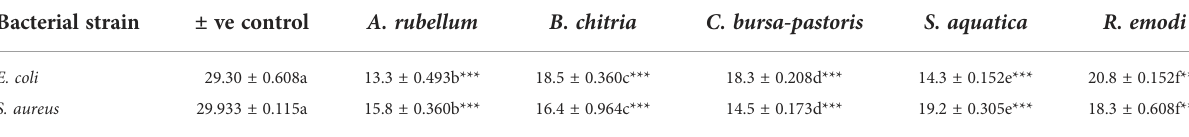
Data are mean ±SD ofthreereplicates (n= 3)and analyzed using GraphPadPrism 5.2bytwo-way ANOVA followed byBonferroni multiple comparison post-testwith a signi fi cance level of ***p < 0.001. Different lowercase letters in a table indicate signi fi cant difference between control and species. Zones of inhibition (mm) are presented as mean ± SEM. E. coli, Escherichia coli; S. aureus, Staphylococcus aureus; Streptomycine (positive